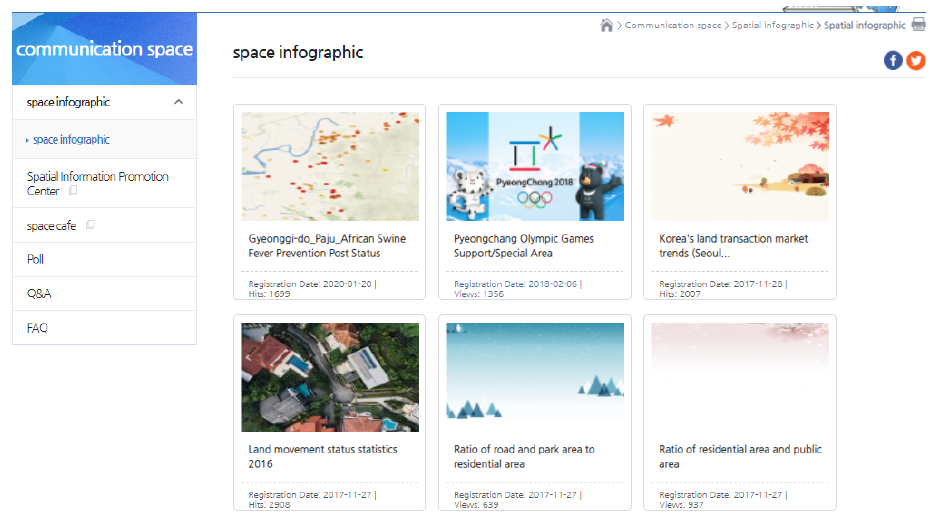
Figure 9. Participation and communication in ‘communication space’.